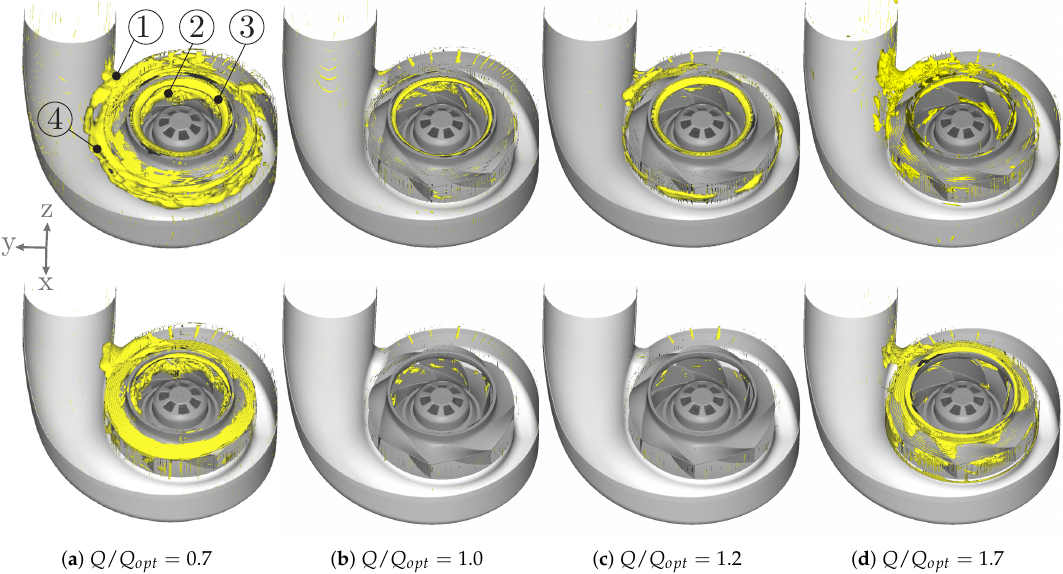
Figure 15. Isosurface of the pressure fluctuation filtered around BPF with values higher than 115dB (top) and in a broadband range of 100–2500 Hz with values higher than 127.5dB (bottom); the numbers mark the identified main noise source locations: 1 (cid:13) tongue area; 2 (cid:13) blade passage; 3 (cid:13) gap between impeller and housing; 4 (cid:13) wake of the impeller’s trailing edge.